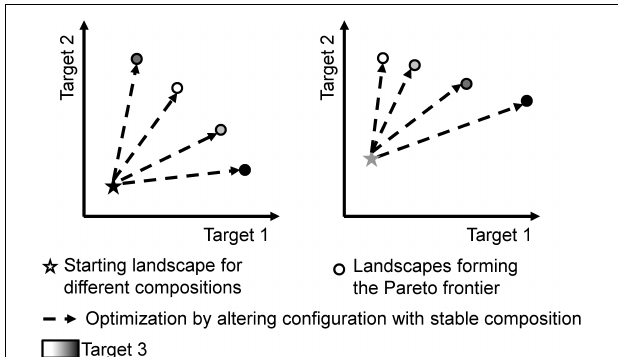
FIGURE 1 | Stylized representation of our optimization approach to explore the effects of landscape composition and configuration. Each scatterplot indicates the levels for three target functions (location and color of the symbols) before (stars) and after (dots) the optimization. The right and left panes of the figure symbolize landscapes with different composition having different values before optimization as well as for their Pareto